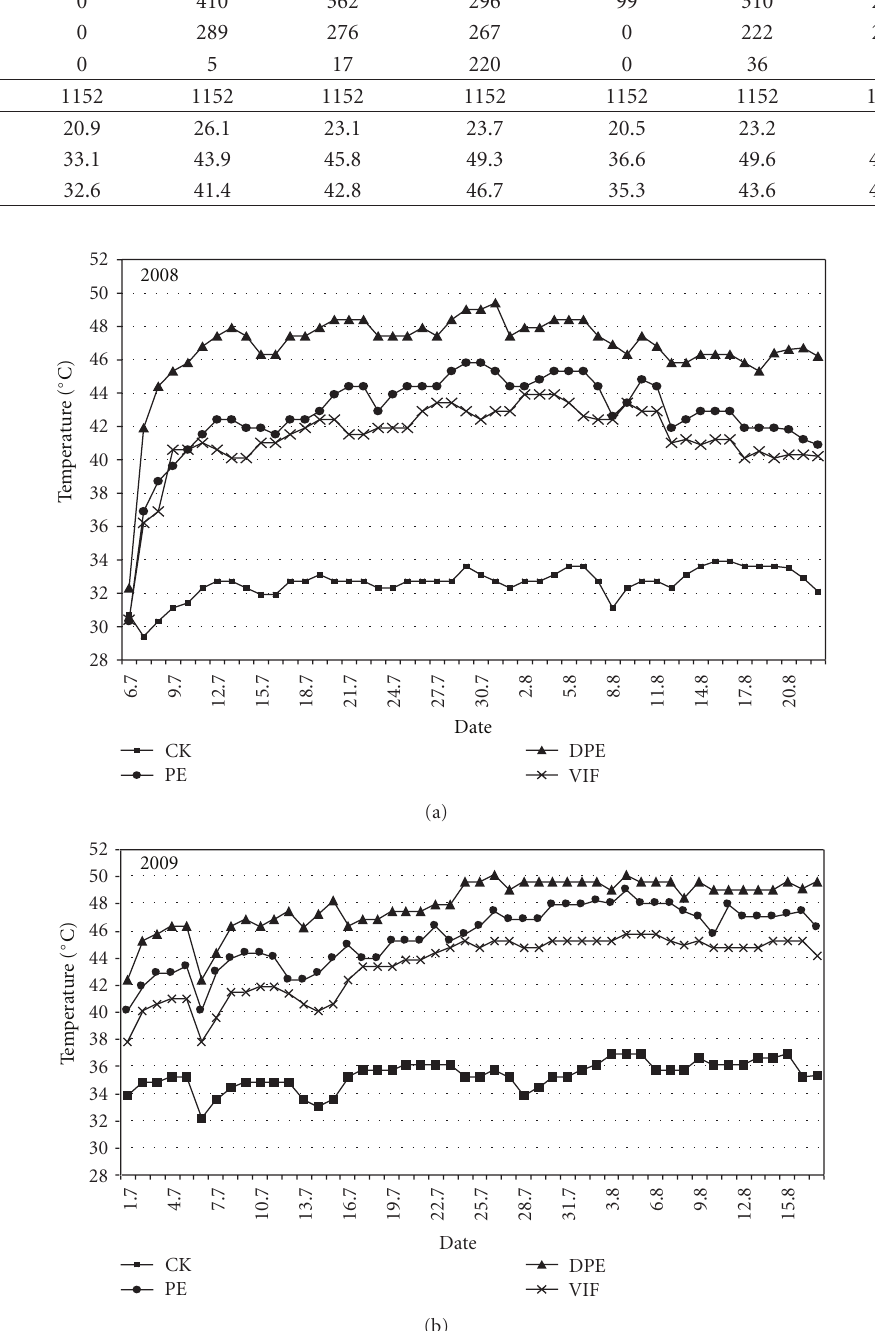
Figure 1: Maximum temperatures recorded under solarization treatments, regular polyethylene (PE), double regular polyethylene (DPE), virtually impermeable films (VIF), and nonsolarized soil (CK) from July 6-August 22, 2008 and July 1-August 17, 2009 in Al-Aroub Agricultural Research Station, South of the West